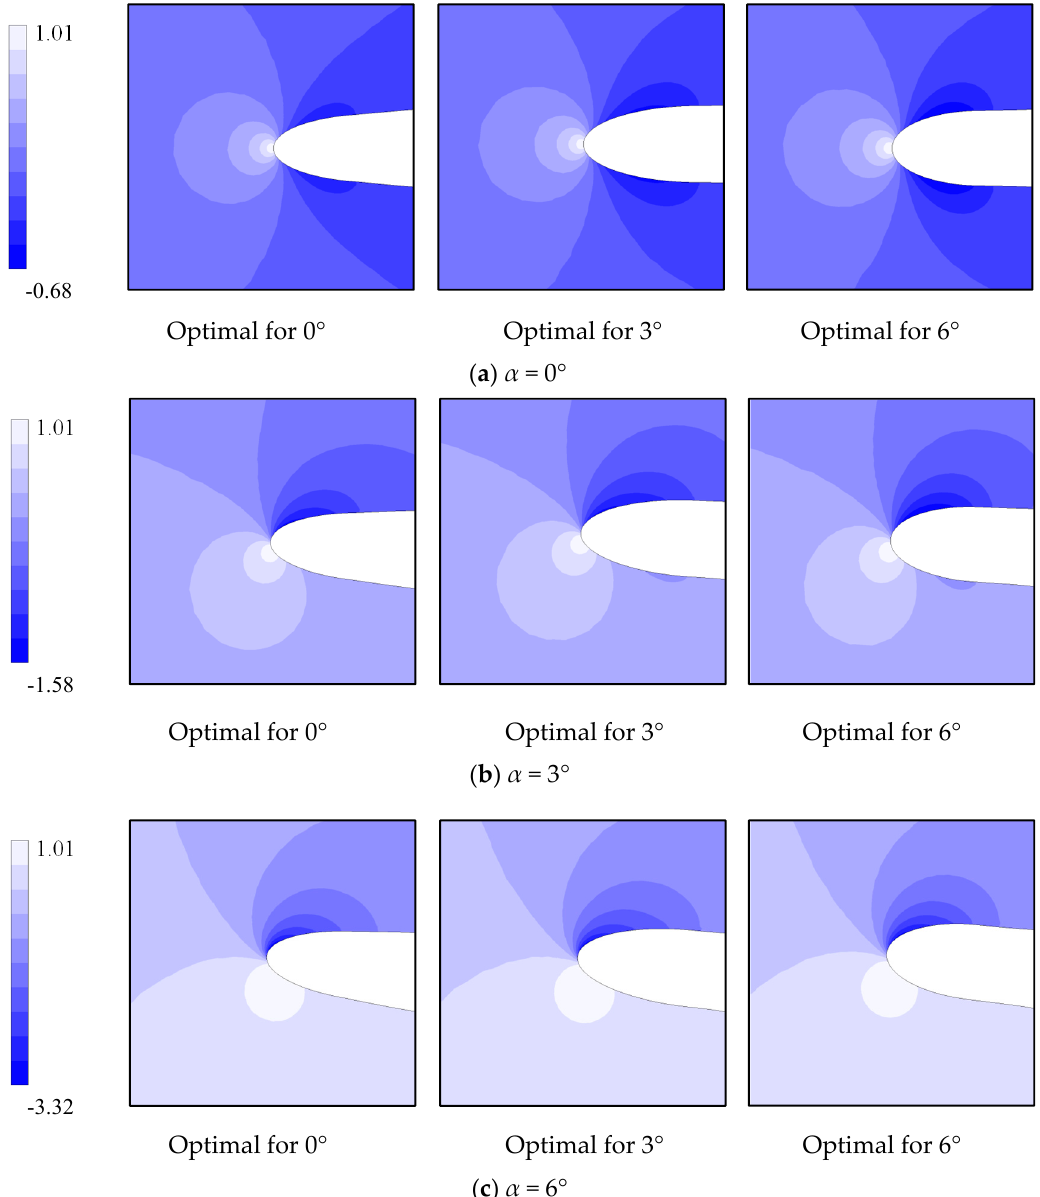
Figure 9. Contour of the dimensionless pressure coefficient C p .